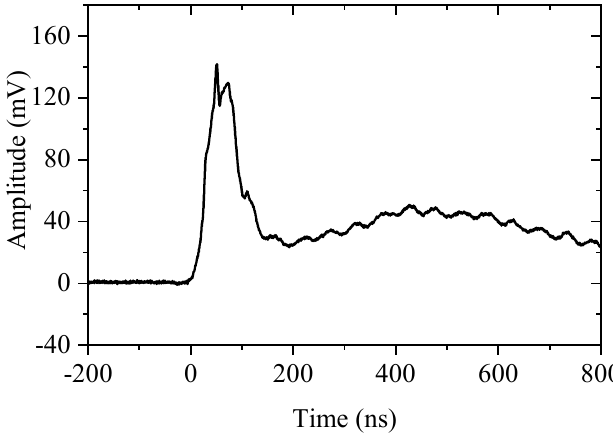
Figure 11. Typical SGEMP measurement waveform.